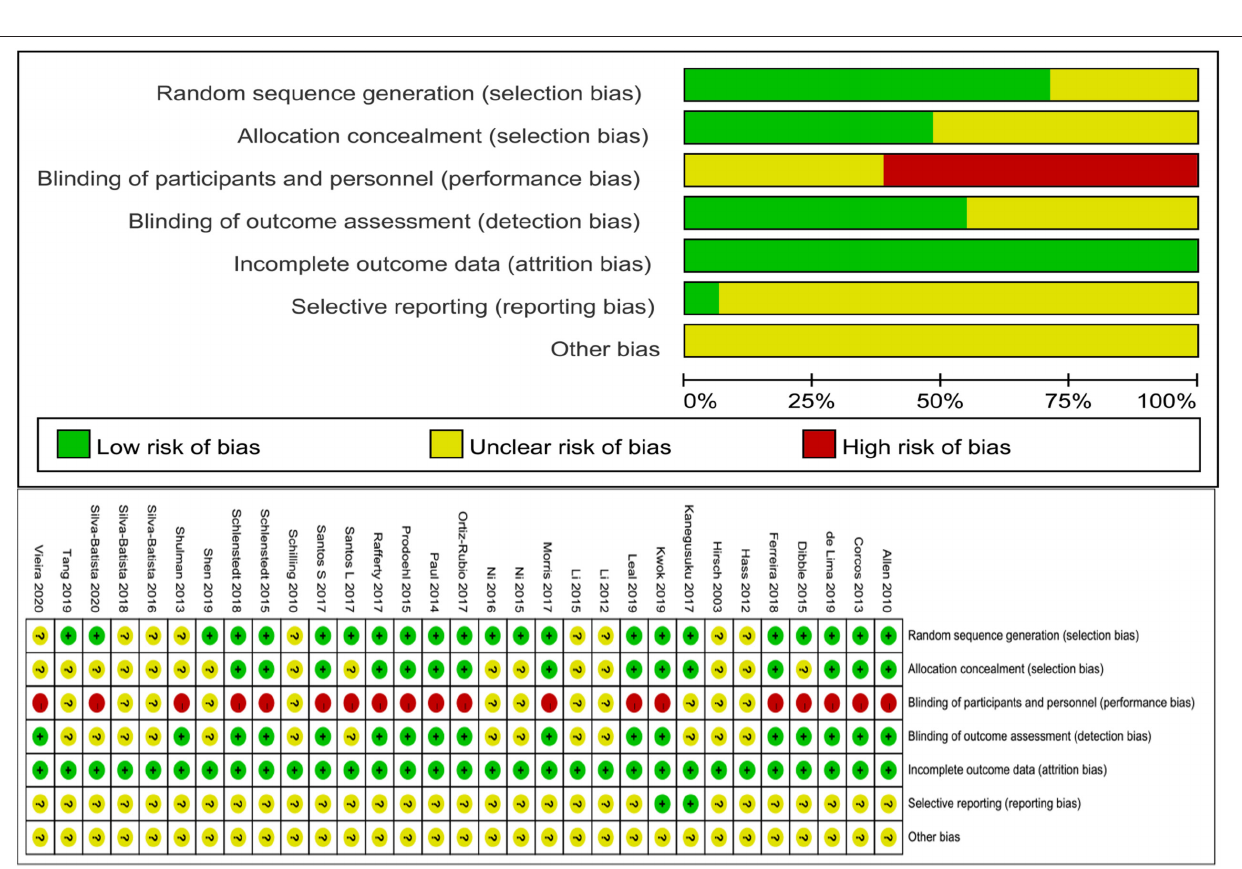
FIGURE 2 | Quality of the included articles by the bias risk assessment based on the Cochrane collaboration